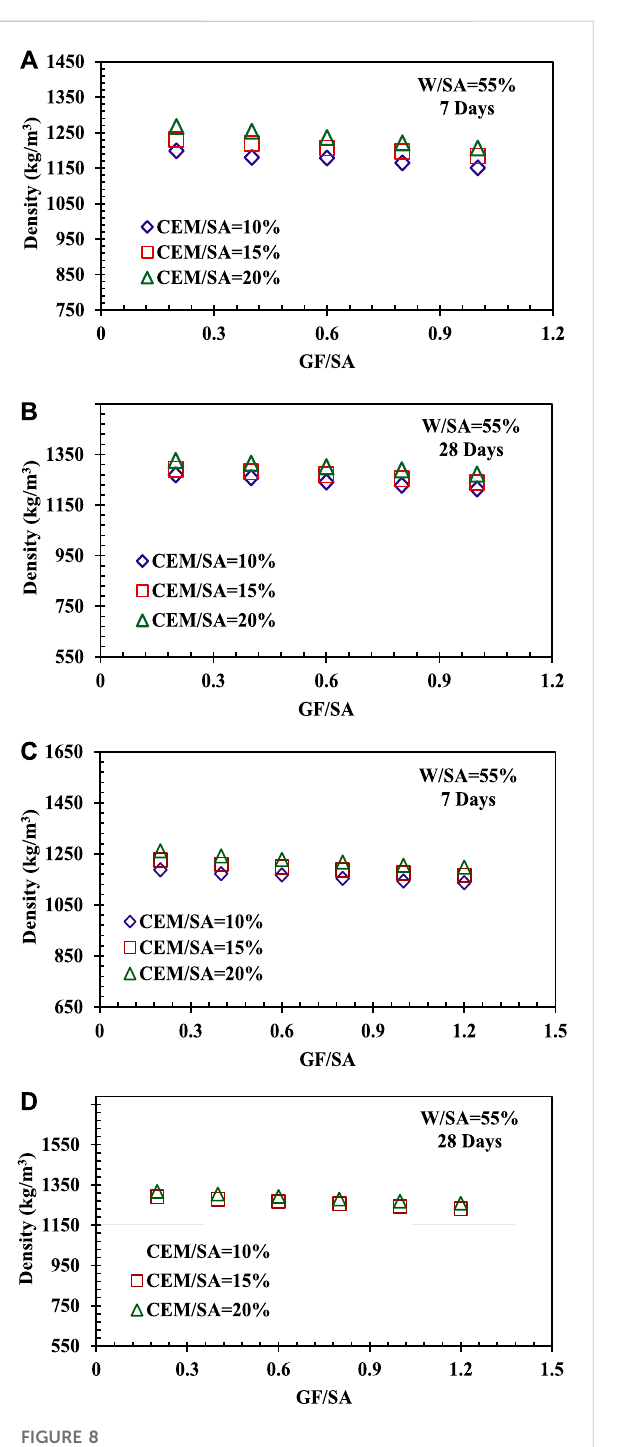
FIGURE 8 Density of prepared materials for (A) 7 days and (B) 28 for cubes; (C) 7 days and (D) 28 days for beams with respect to the mix value.